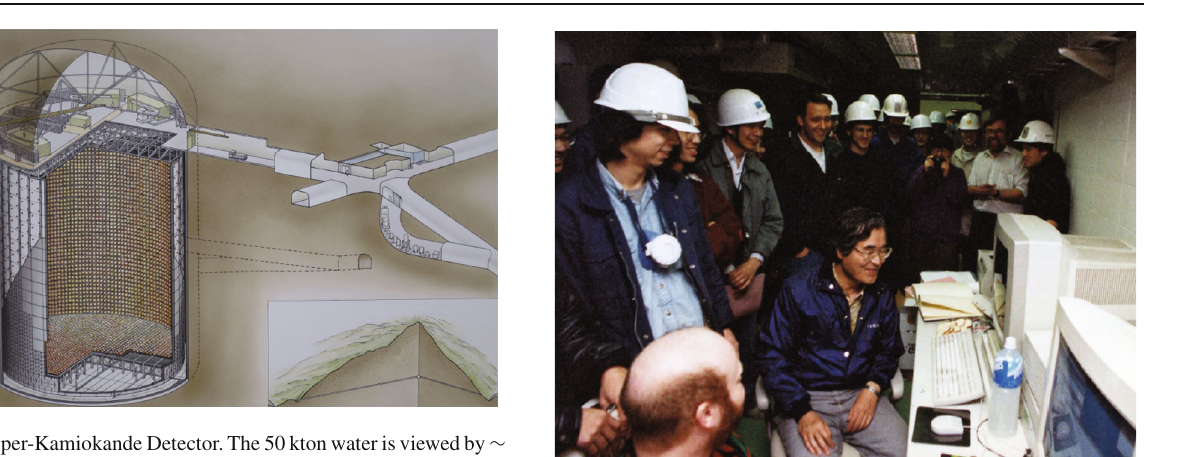
thephotomultipliertubes(PMTs),electronicsanddataacqui- sition system. We had started to fill the detector with water in January, 1996. Figure 2. shows the moment when Yoji Tot- suka pressed the button to start the experiment punctually at 0:00 on April 1st,